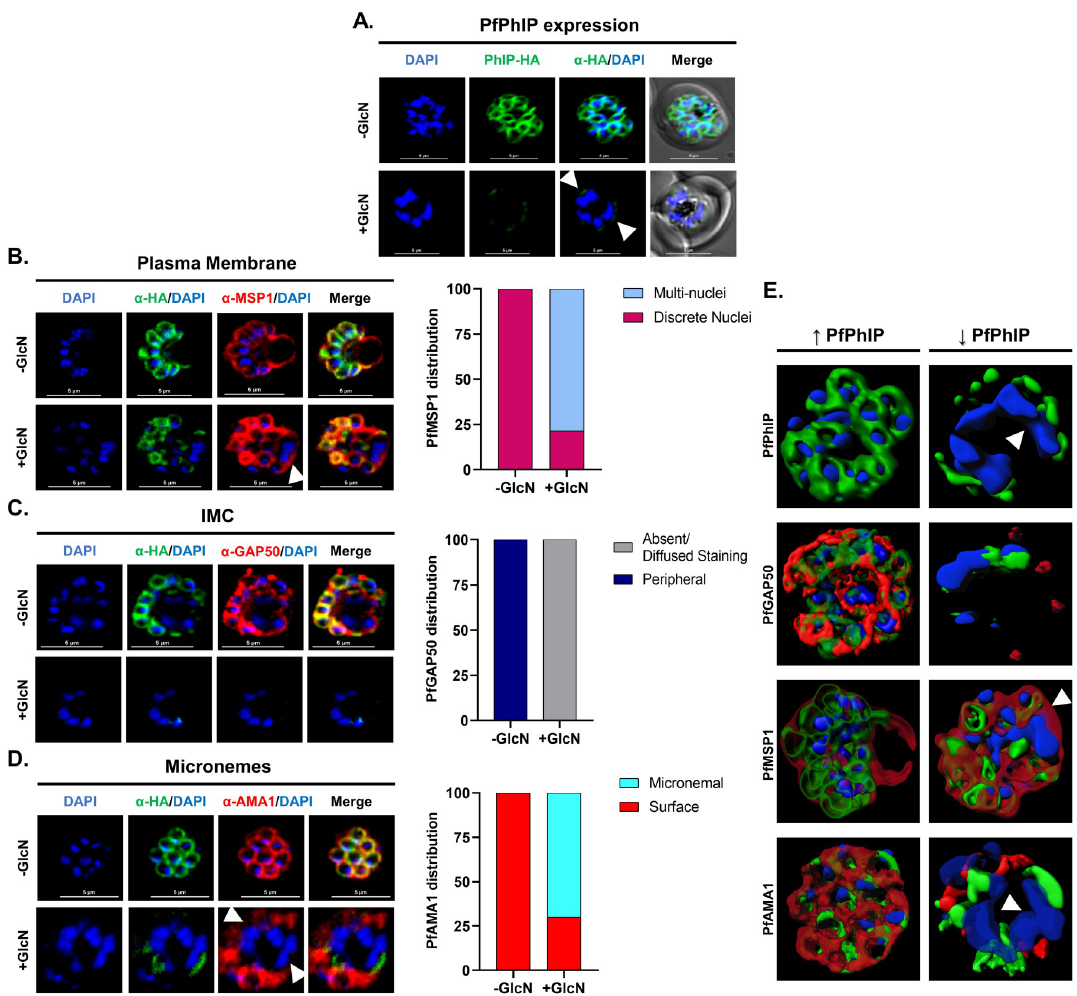
Fig 4. PfPhIP deficient parasites show defects in the segmentation of daughter cells. PfPhIP-HA- glmS parasites maintained with and without GlcN were E64-treated (10 μ M) and probed with the anti-HA antibody (green) and counterstained with DAPI. (A) Apparent knockdown of PhIP expression leads to the formation of agglomerates of unsegmented daughter nuclei. (B) Anti-GAP50 antibody (IMC marker) (red) showed defects in IMC formation in agglomerates. Merozoite plasma membrane and micronemes were stained with antibodies against P . falciparum (C) merozoite surface protein 1 (PfMSP1) (red) and (D) PfAMA1 (red), respectively, in E64-treated schizonts cultivated with and without GlcN. PfMSP1 was visible in schizonts but forms relatively larger rings that surround multiple nuclei in the agglomerates. PfAMA1 showed a loss of signal in agglomerates. Scale bar = 5 μ m. Based upon the staining pattern parasites were grouped and the percentage parasites in each group are presented in the bar graphs. (E) 3D reconstruction of the PfPhIP-HA- glmS schizonts with and without GlcN is presented using Imaris 7.6.1. Arrowheads indicate agglomerates of unsegmented daughter nuclei. See also S5 and S6 Figs.